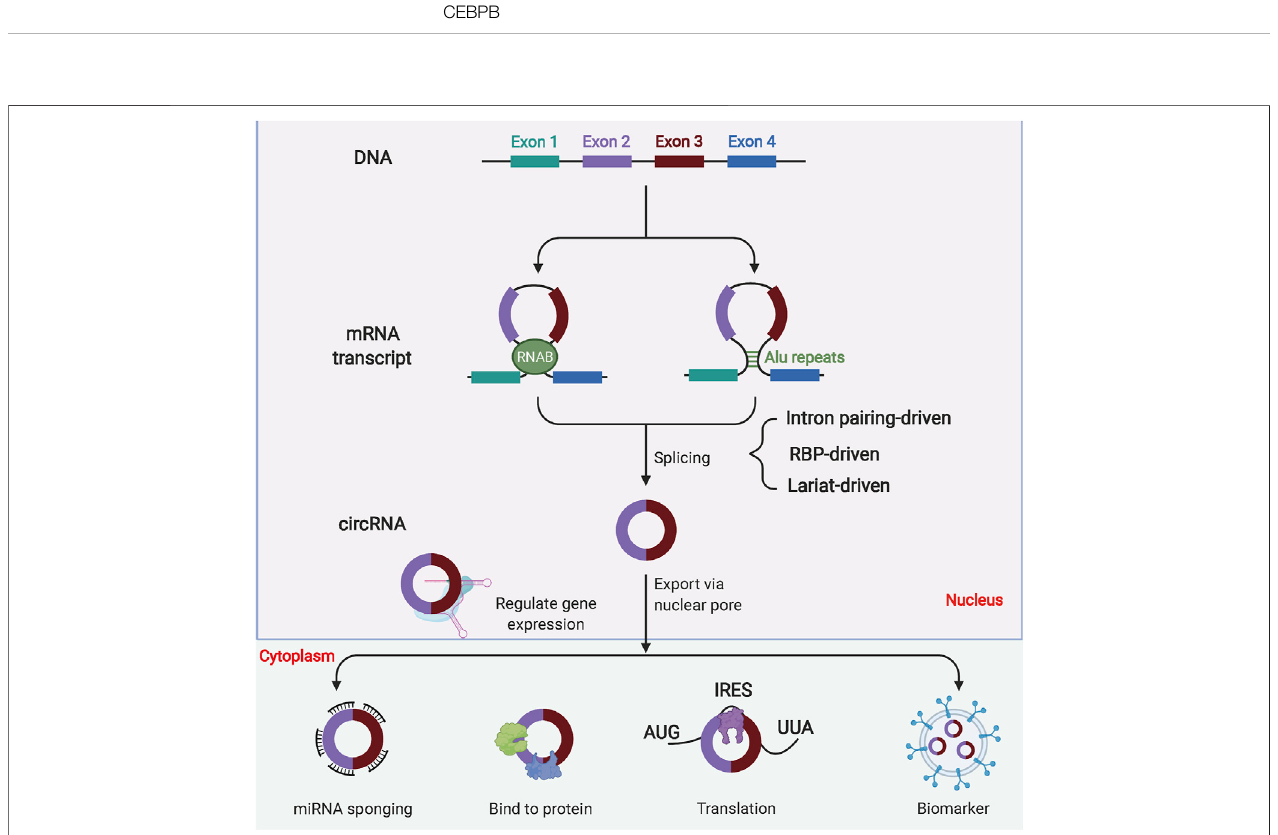
FIGURE 5 | Biogenesis of circular RNAs (circRNAs). Most circRNAs are derived from pre-mRNA. Due to their composition, circRNAs are classi fi ed into several types, including exonic circRNAs, exon-intron circRNAs and intronic circRNAs. CircRNAs can perform biological functions by binding miRNAs, binding proteins or translating into polypeptides. In addition, circRNAs are also enriched in exosomes and are good markers for disease diagnosis.